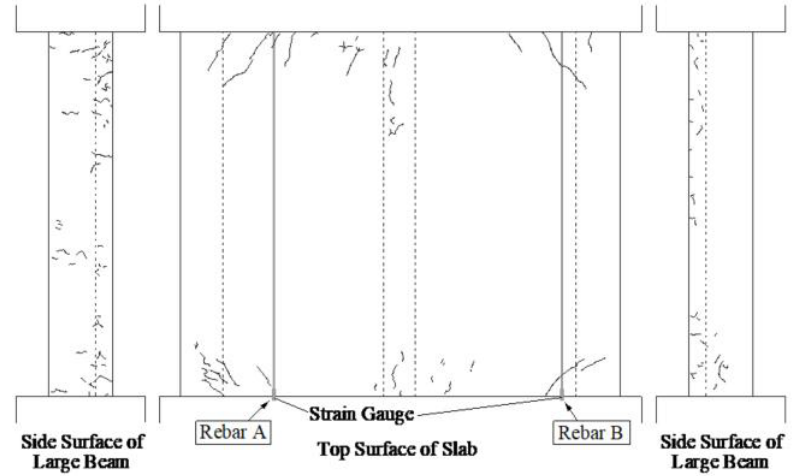
Figure 8. Shrinkage cracks after 318 days of drying (A and B show the locations of rebars that correspond to those in Figures 1 and